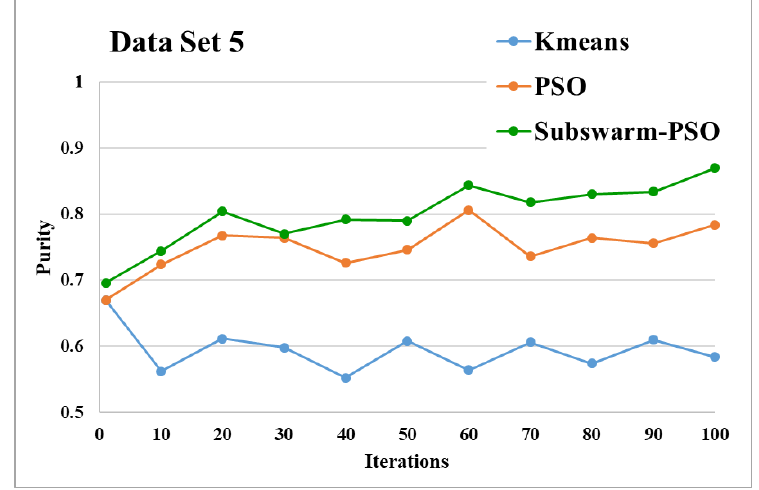
Figure 13. Purity comparison for data set 5.